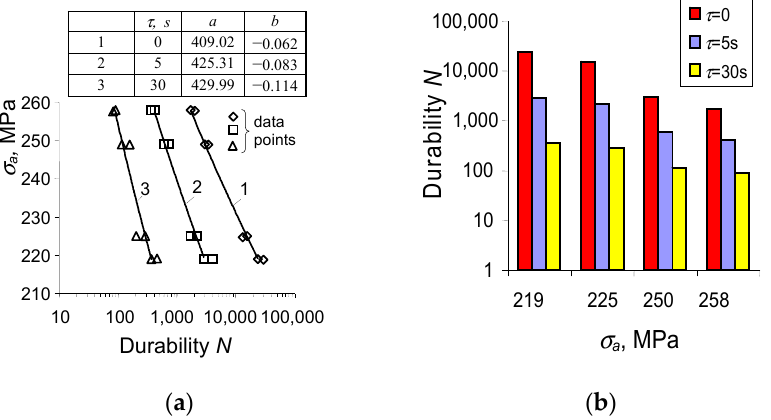
Figure 12. Durability results (experiment): ( a ) fatigue curves, ( b ) summary of durability results.